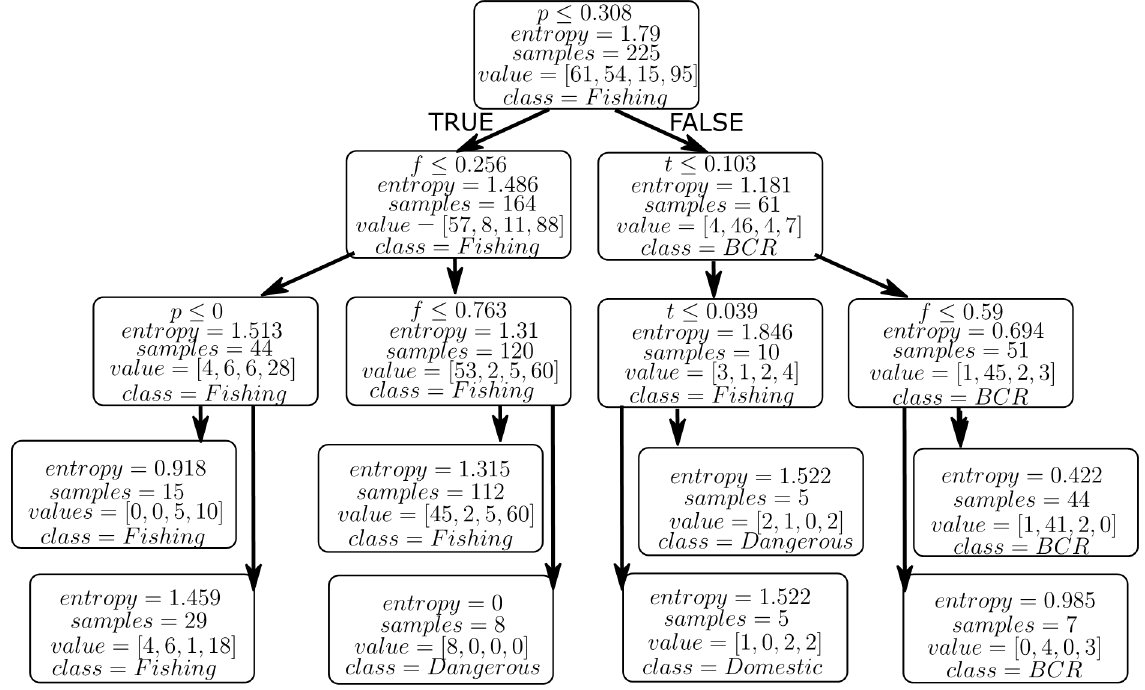
Figure 9. The Decision Tree developed using the ID3